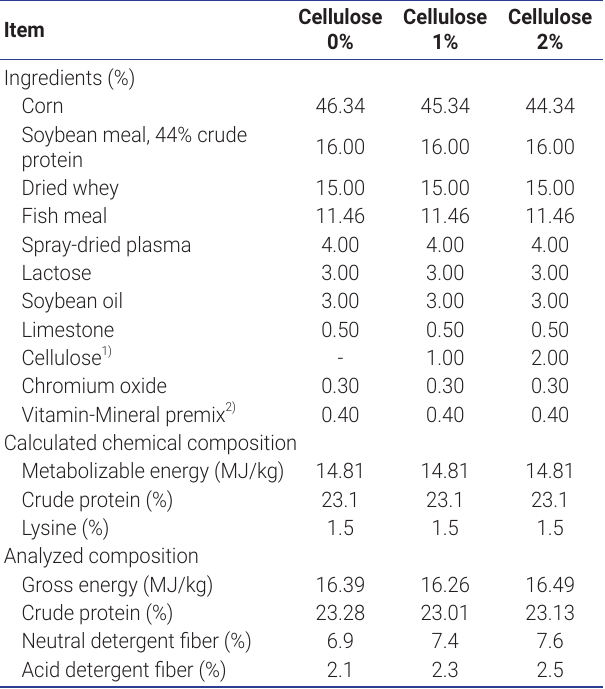
Table 1. Composition of the experimental diet (as-fed